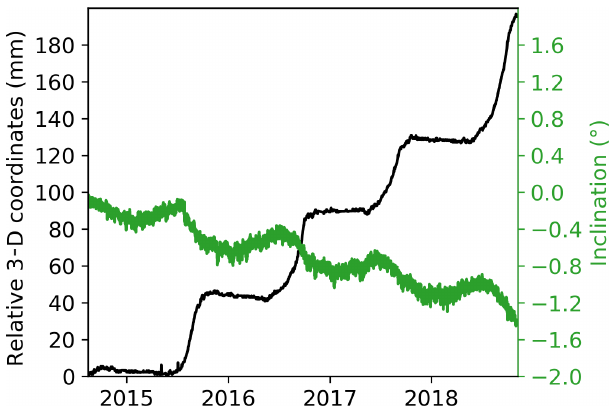
Figure 14. Displacement (black) and inclination (green) measured using an L1-GPS sensor for deriving displacement based on daily position data and an integrated two-axis inclinometer sensor at po- sition MH34 (the tower feature in the middle of Fig.